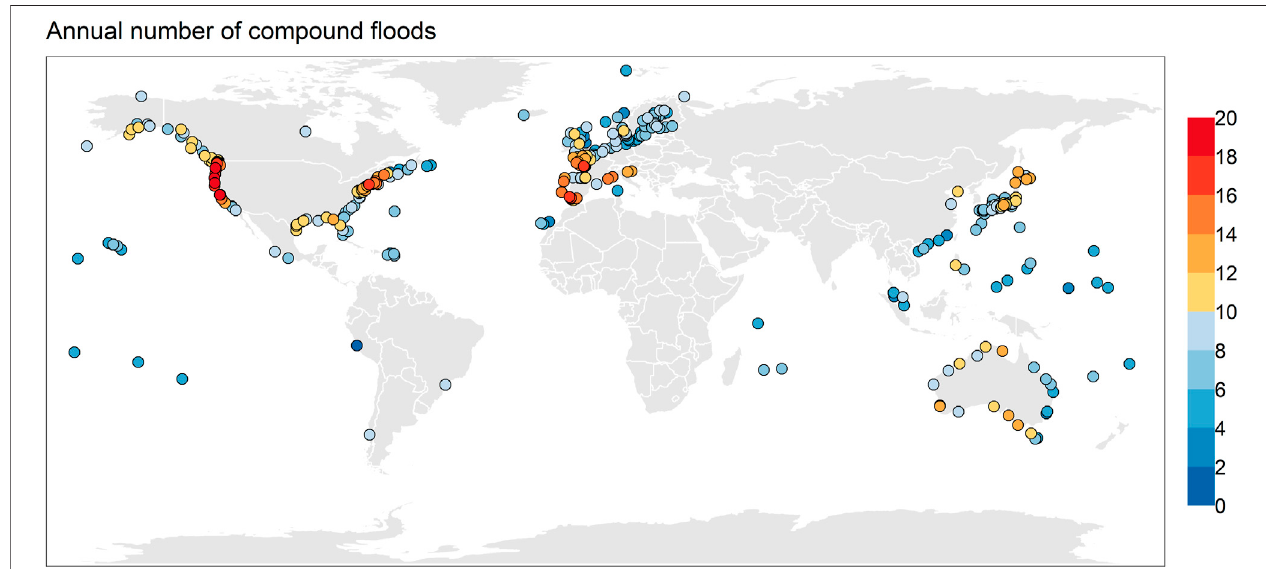
FIGURE 2 | The annual number of compound fl ood days. Compound fl ood days are the days with extreme precipitation and extreme storm surge exceeding the 90th percentile values.